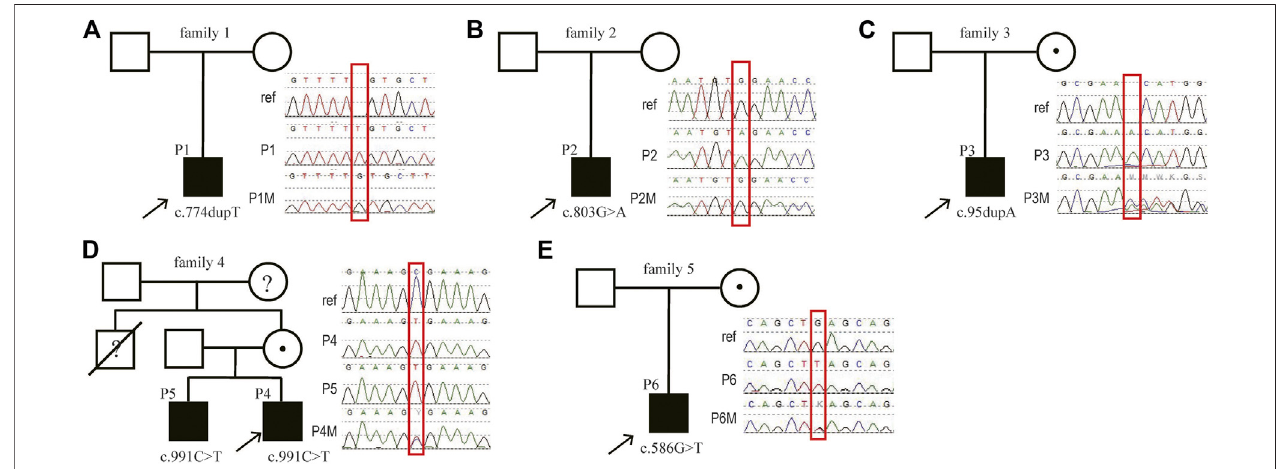
FIGURE2| Identi fi cationandvalidationofthe MAGT1 variantsinsixpatientswithXMENdiseaseinthisstudy.Pedigreesofpatient1 (A) ,patient2 (B) ,patient3 (C) , patient 4 and 5 (D) and patient 6 (E) carrying disease-causing variants in the MAGT1 gene. P , patient; M , mother; ref , reference